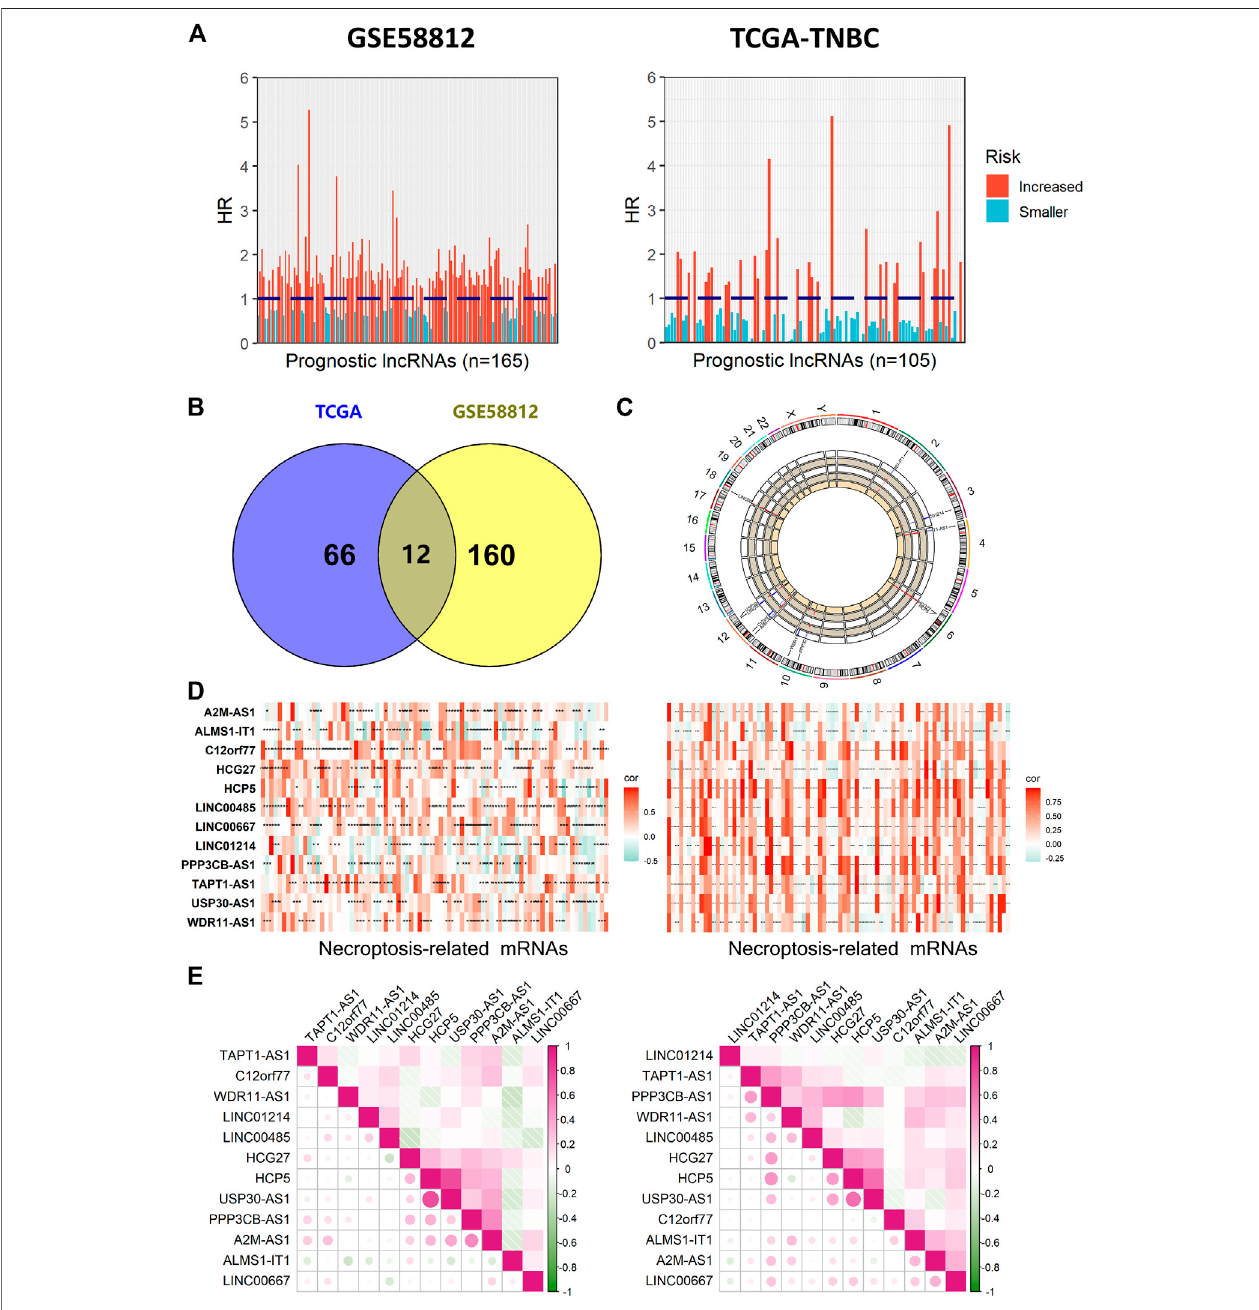
FIGURE 2 | Identi fi cation of prognostic necroptosis-related lncRNAs in patients with TNBC. (A) Results of univariate Cox regression of OS with 165 lncRNAs in GSE58812 and 105 lncRNAs in TCGA. (B) Venn diagram to identify common lncRNAs of GSE58812 and TCGA cohorts. (C) Circos plot representing the position and expression levels of 12 necroptosis-related lncRNAs. (D) Pearson correlation coef fi cient (r) between necroptosis-related lncRNA and the corresponding mRNA was calculated and shown by heat map (***, **, and * indicate p < 0.001, < 0.01, and < 0.05, respectively). (E) Demonstration of correlations between the 12 signi fi cant lncRNAs from each